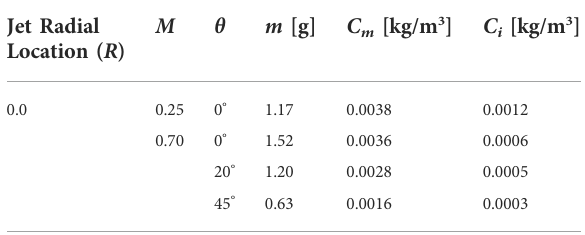
TABLE 2 Concentration study